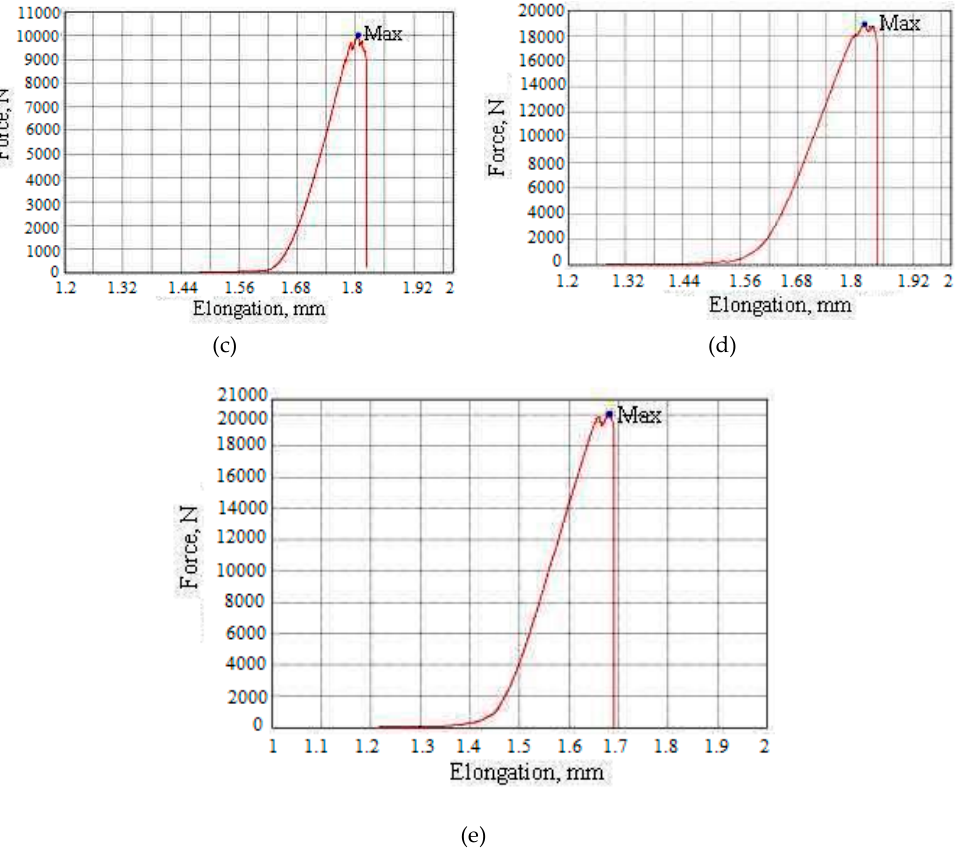
Figure 16. Curve force and elongation: ( a ) Sample 1; ( b ) Sample 2; ( c ) Sample 3; ( d ) Sample 4; ( e ) Sample 5. Table 8. Characteristics of compacted SiO 2 nanopowder samples during compressive strength tests.